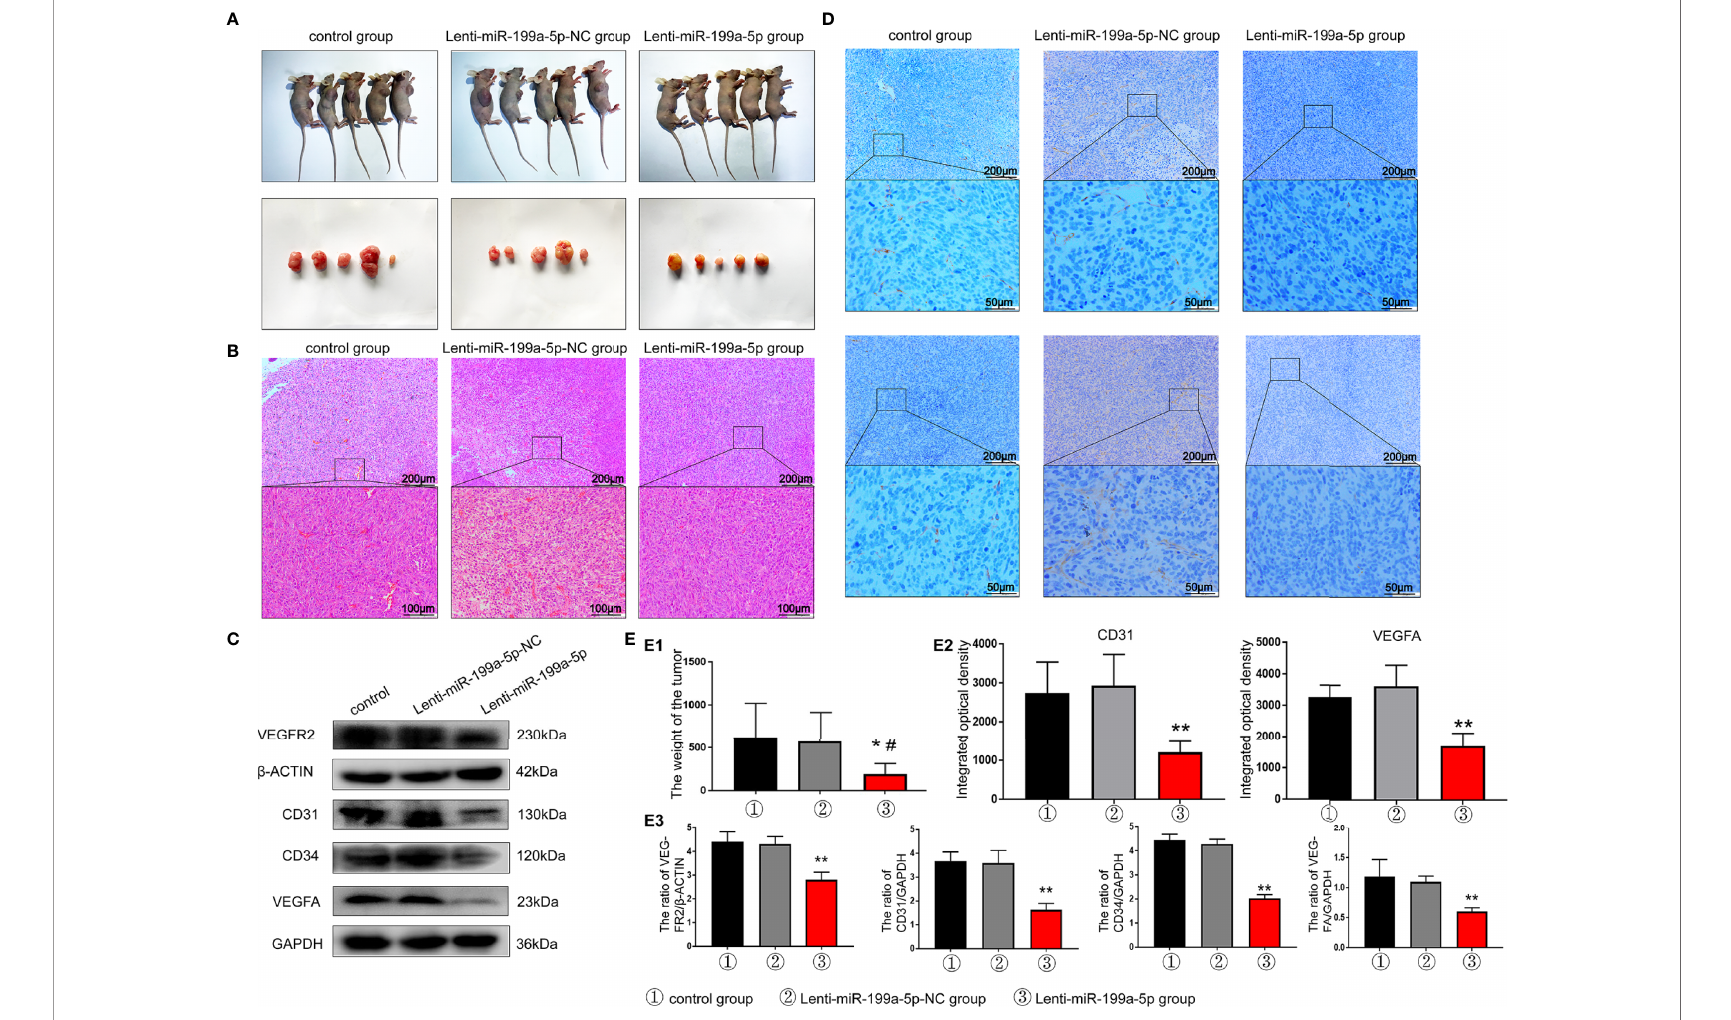
FIGURE 7 | Results of tumor formation experiment in nude mice. (A) Photographs of nude mice and tumor in each group. (B) H&E staining results of tumor sections indicated that the number of tumor vascular tissues in the Lenti-miR-199a-5p group decreased. (C) western blot analysis showed that the protein expression levels of VEGFR2, CD31, CD34 and VEGFA protein were markedly increased in the tumor tissue of Lenti-miR-199a-5p group. (D) The immunohistochemical analysis of miR-199a-5p inhibited osteogenesis in vivo . Immunohistochemical analysis of CD31 and VEGFA was used to detect osteogenesis in the tumor sections. The brown color represents positive staining of CD31 and VEGFA. (E) Experimental quantitative data. E1, Comparison of tumor weight between the three groups. E2, The integrated optical density of positive staining was measured by Image-Pro Plus 6.0 software. E3, Quantitative data analysis of western blot results. ** represents P < 0.01vs other groups. *P < 0.05 represents P < 0.05 vs other